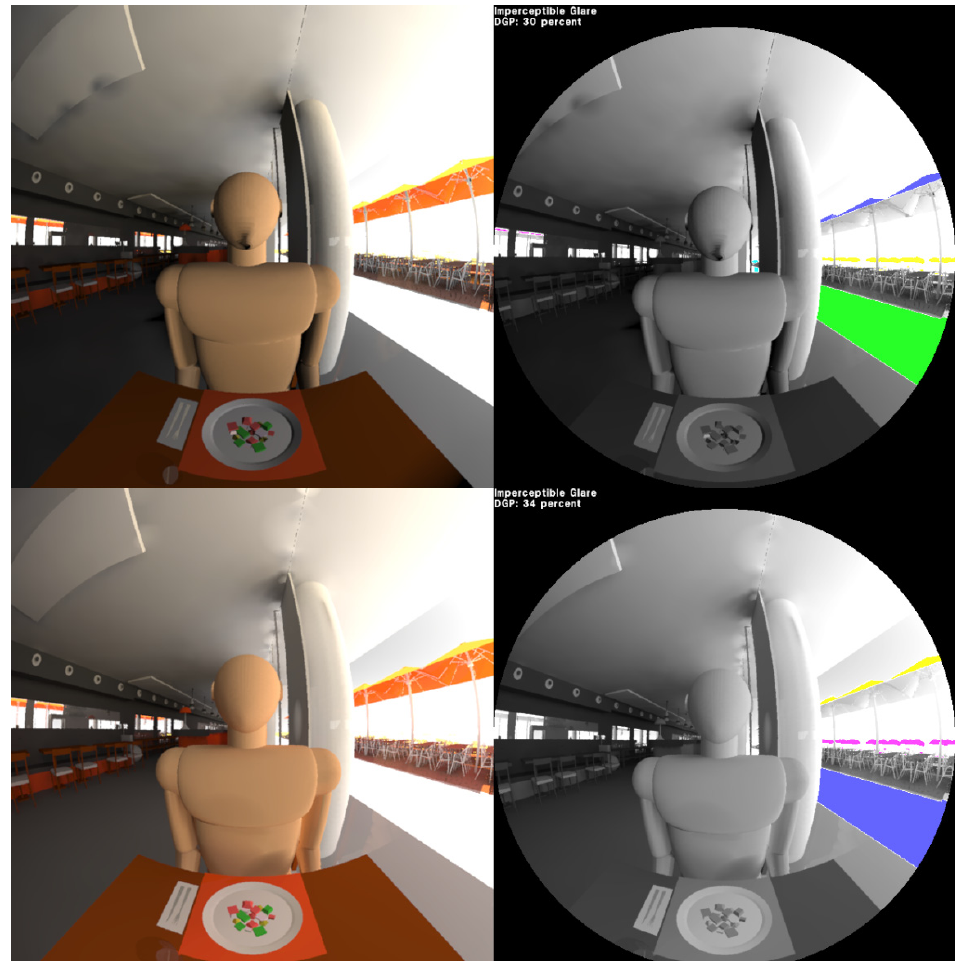
Figure 4 . Low quality and Medium quality visualization and Daylight Glare Probability (DGP) result with glare source image of second workplane; person in front.